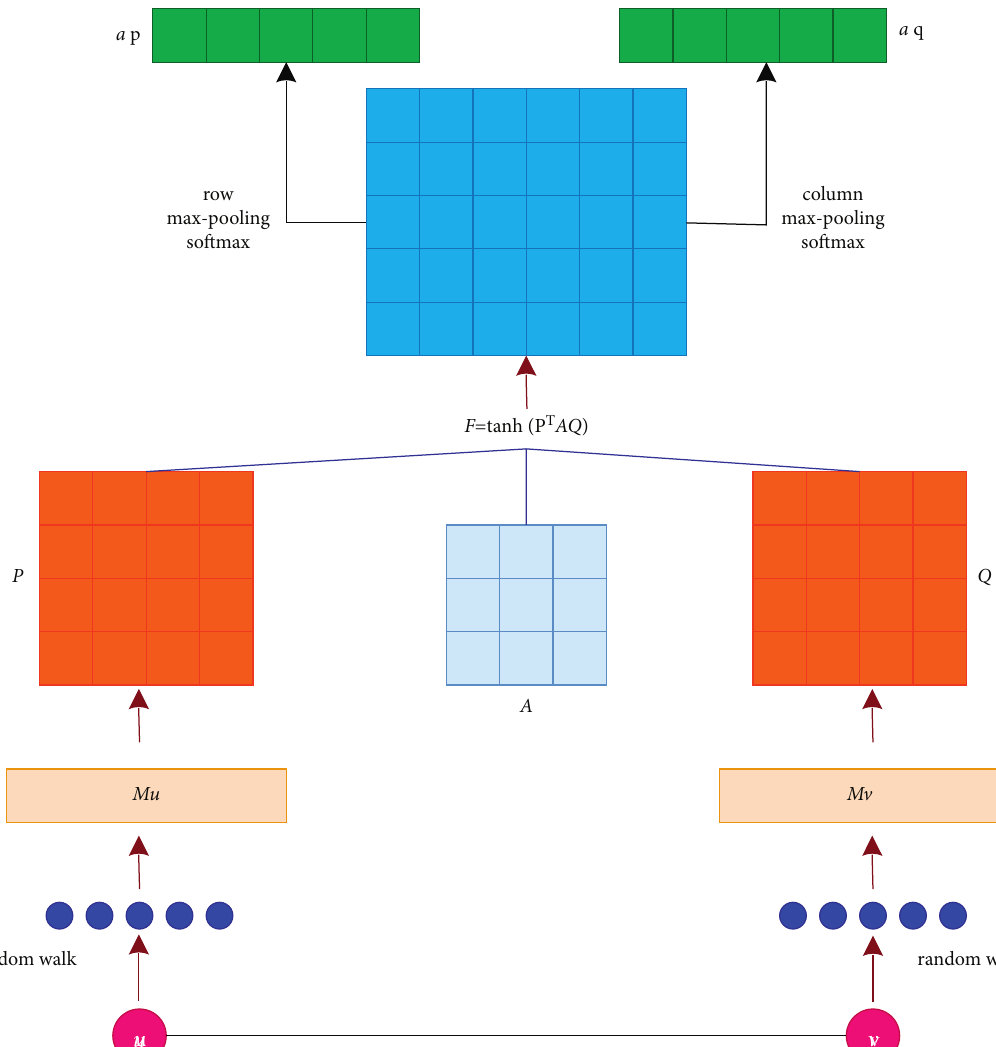
Figure 3: Algorithm framework based on neural network and